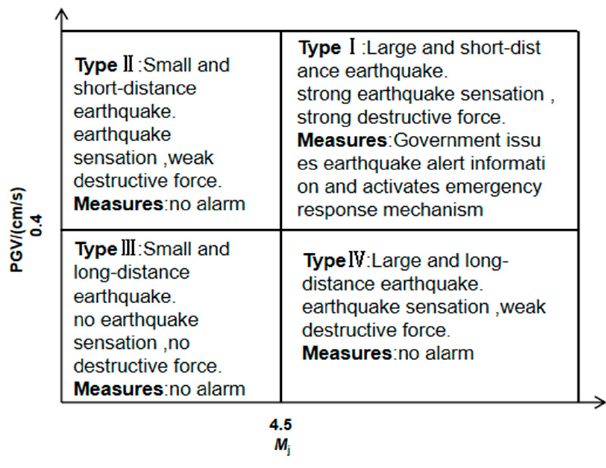
Figure 4. Seismic judgment model.